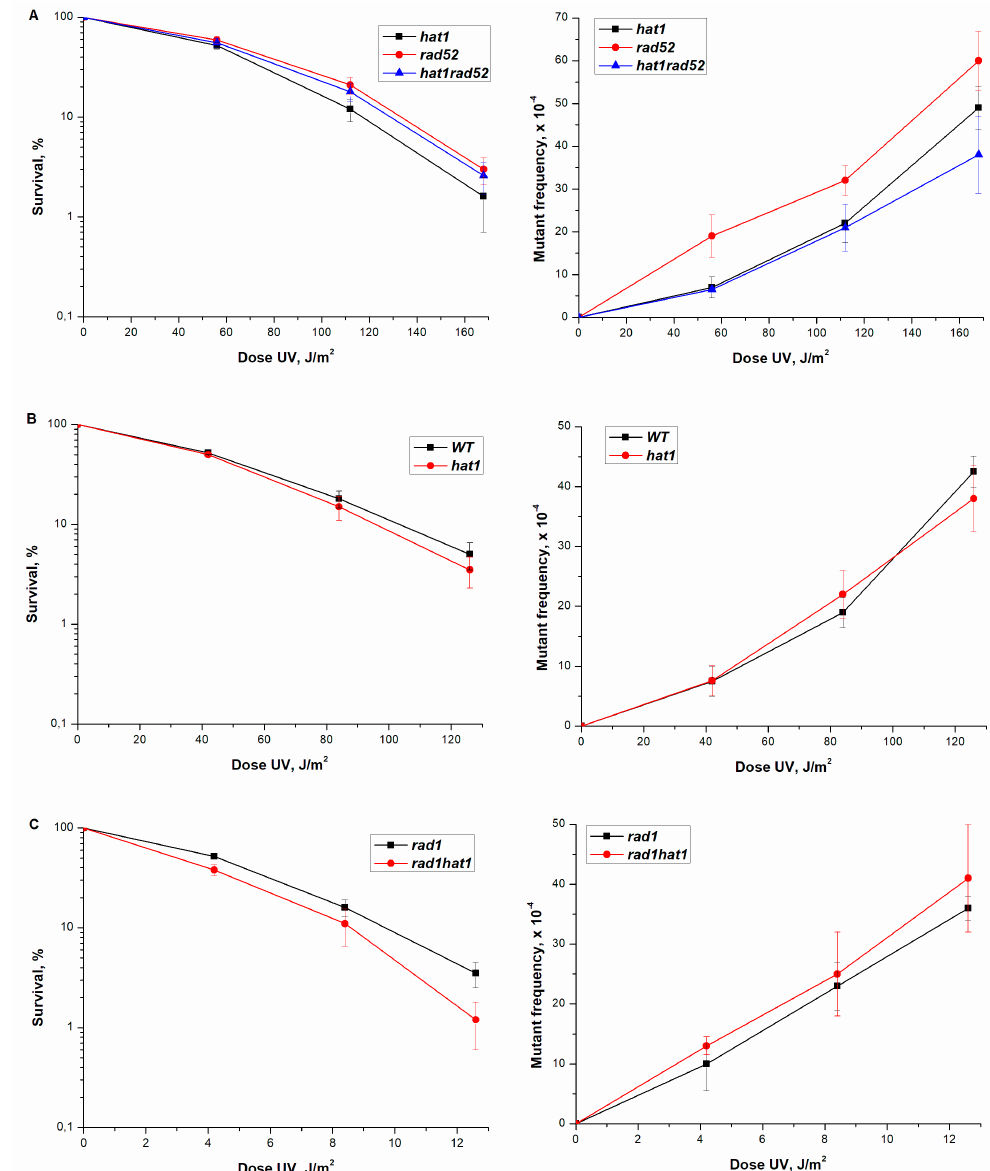
Figure 3. Sensitivity and mutagenesis in different strains after UV irradiation at different doses. The viable titer was determined, and the percentage of survivals was calculated. The mean ± SEM values obtained from 4 independent experiments are plotted. ( A ) UV-sensitivity and mutation frequency in mutant strains hat1 Δ (CAY-2), rad52 Δ (10-CAY-3031), hat1 Δ rad52 Δ (CAY-4); ( B ) UV-sensitivity and mutation frequency in strain wild-type (LMG-3031) and mutant strain hat1 Δ (CAY-2); ( C ) UV-sensitivity and mutation frequency in mutant strains rad1 Δ (LMG-351), rad1 Δ hat1 Δ (CAY-6).